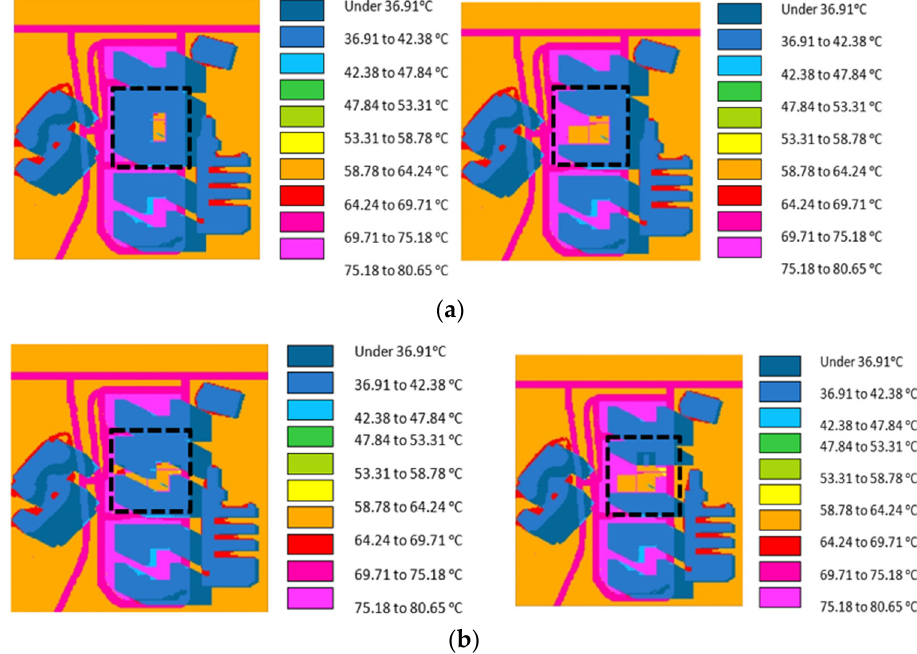
Figure 16. ( a ) Predicted mean radiant temperature bands at 0 m above the ground level at 4 p.m. in the FBTS models (Left—courtyard; Right—U model). ( b ) Predicted mean radiant temperature bands at 0 m above the ground level at 4 p.m. in the FBTS models (Left—courtyard canyon; Right—canyon).